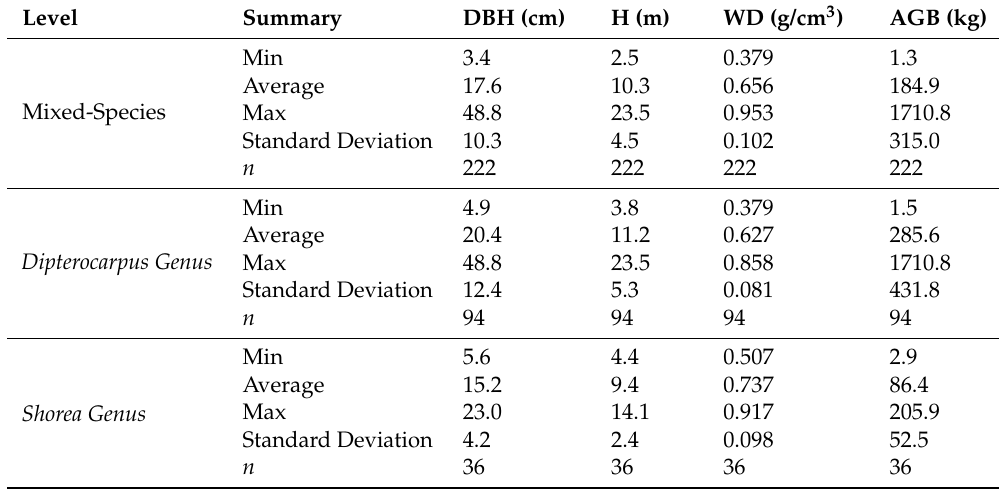
Table 2. Summary for each of the predictors and the response variables of the destructively sampled trees for mixed-species and two main